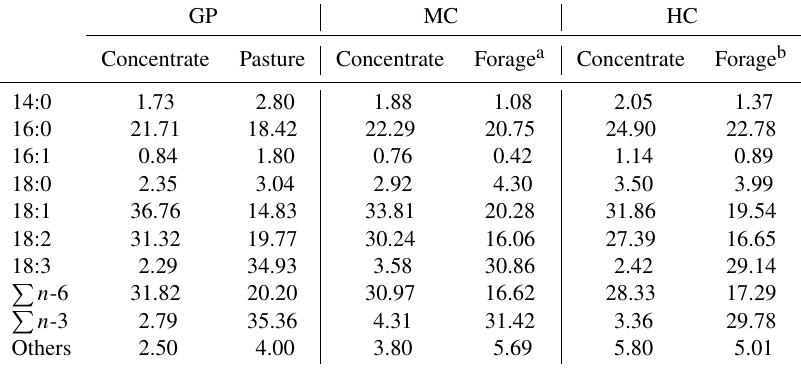
Table 2. Fatty acid profile (expressed as percent of total fatty acids detected) in the treatments based on grass pasture (GP) and medium (MC) and high (HC) levels of concentrate in the diet. GP MC HC Concentrate Pasture Concentrate Forage a Concentrate Forage b 14:0 1.73 2.80 1.88 1.08 2.05 1.37 16:0 21.71 18.42 22.29 20.75 24.90 22.78 16:1 0.84 1.80 0.76 0.42 18:0 18:1 36.76 18:2 31.32 19.77